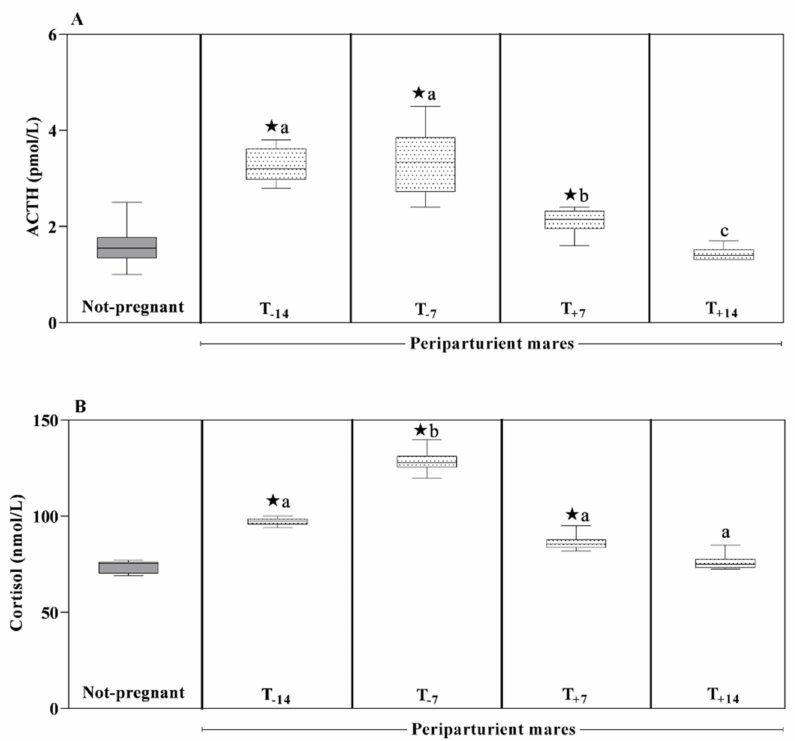
Figure 1. Mean values ± standard deviation (SD) of plasma adrenocorticotrophic hormone (ACTH) ( A ) and serum cortisol ( B ) obtained in pregnant (Group A) and not-pregnant mares (Group B) with relative statistical significances. The symbol “star” ( (cid:70) ) reflects difference significant differences between groups vs. non-pregnant mares ( p < 0.0001); Different alphabetic letters show significant differences within peripartum period ( p < 0.0001).